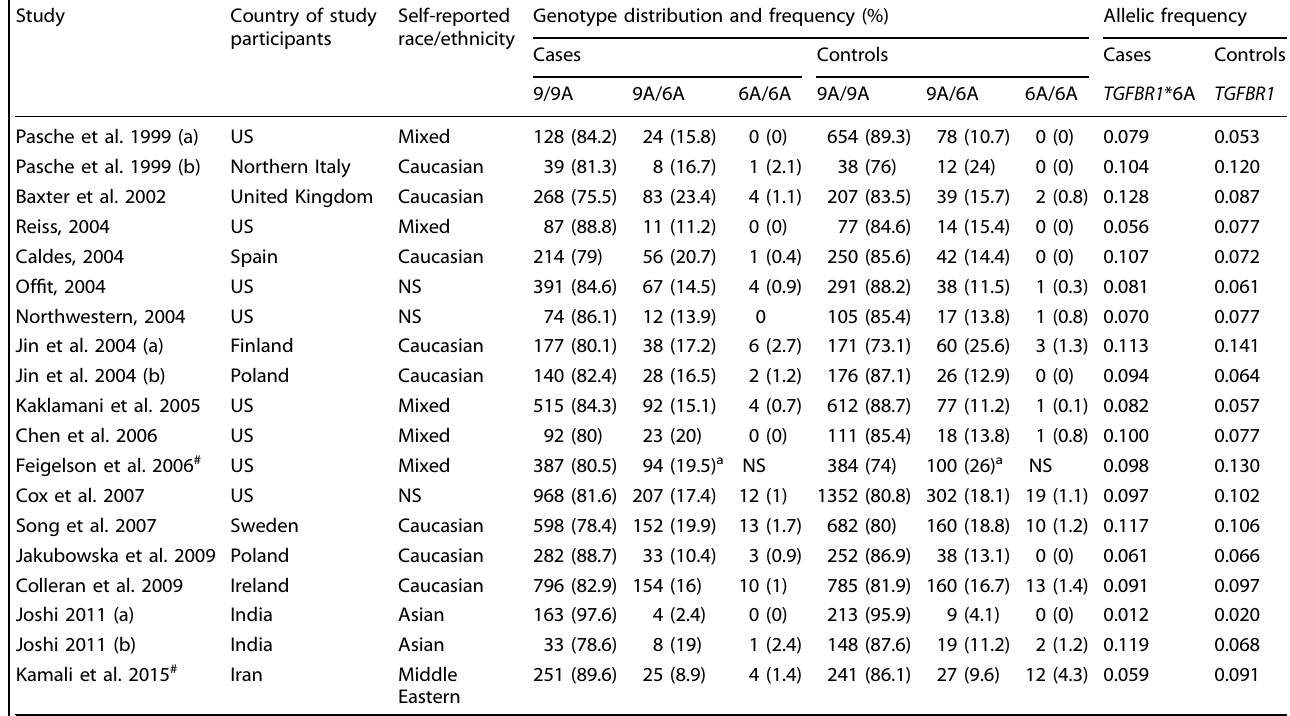
Table 1. Case-control studies showing TGFBR1 *6A genotypic and allelic distribution and frequency.